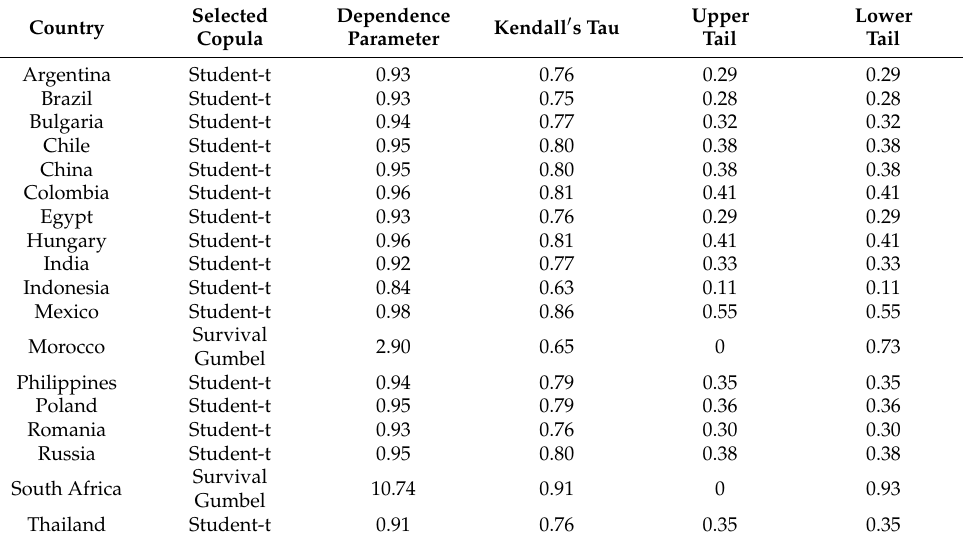
Table 5. The selected static copula dependence, Kendall’s Tau, upper and lower tail dependences between the U.S. and emerging countries.